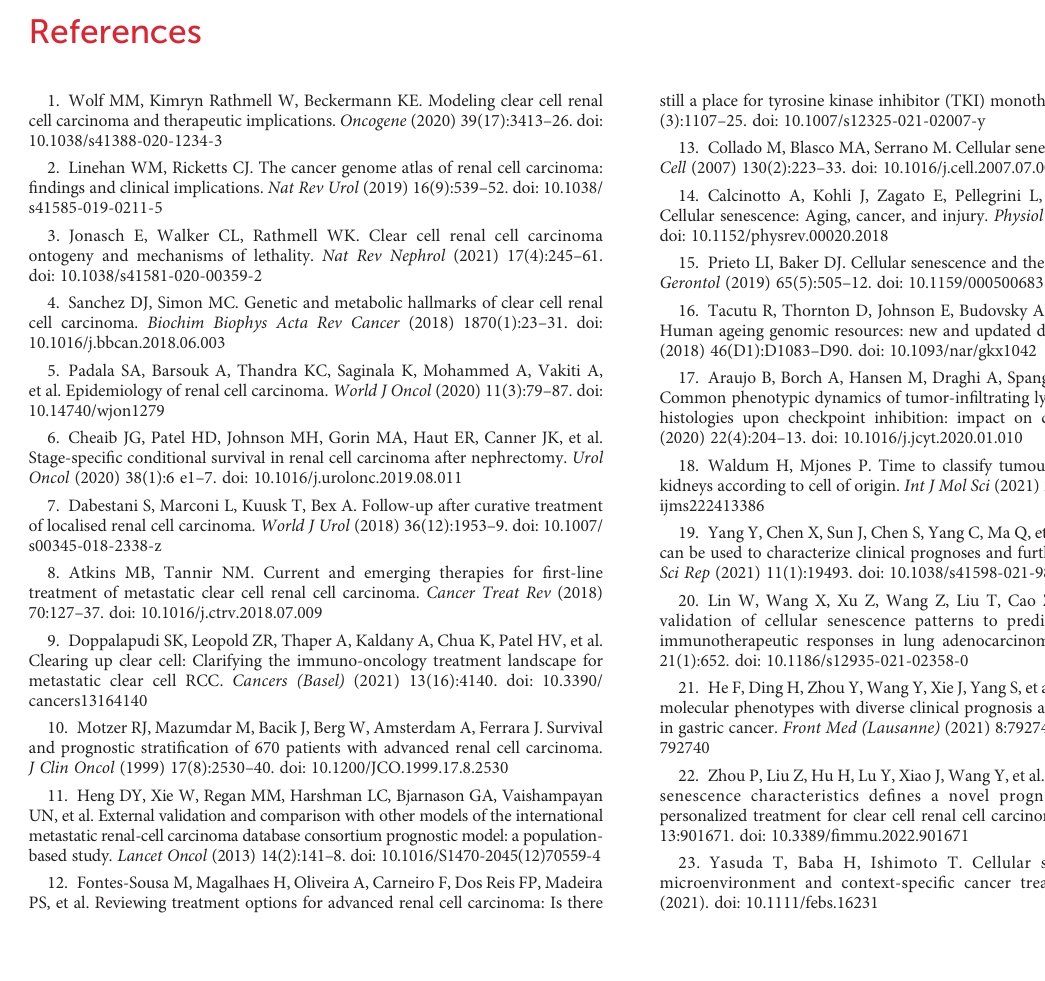
SUPPLEMENTARY FIGURE 1 The fl owchart of this study. SUPPLEMENTARY FIGURE 2 The Venn diagram shows the the number of DEGs between each of the two molecular subtypes. SUPPLEMENTARY FIGURE 3 Survival curves based on the expression of each CS-related gene in the risk model. SUPPLEMENTARY FIGURE 4 mRNA levels of fi ve genes in the risk model in normal kidney cells and ccRCC cells measured by qRT-PCR. Data are shown as mean ± SD, *p<0.05, **p<0.01,